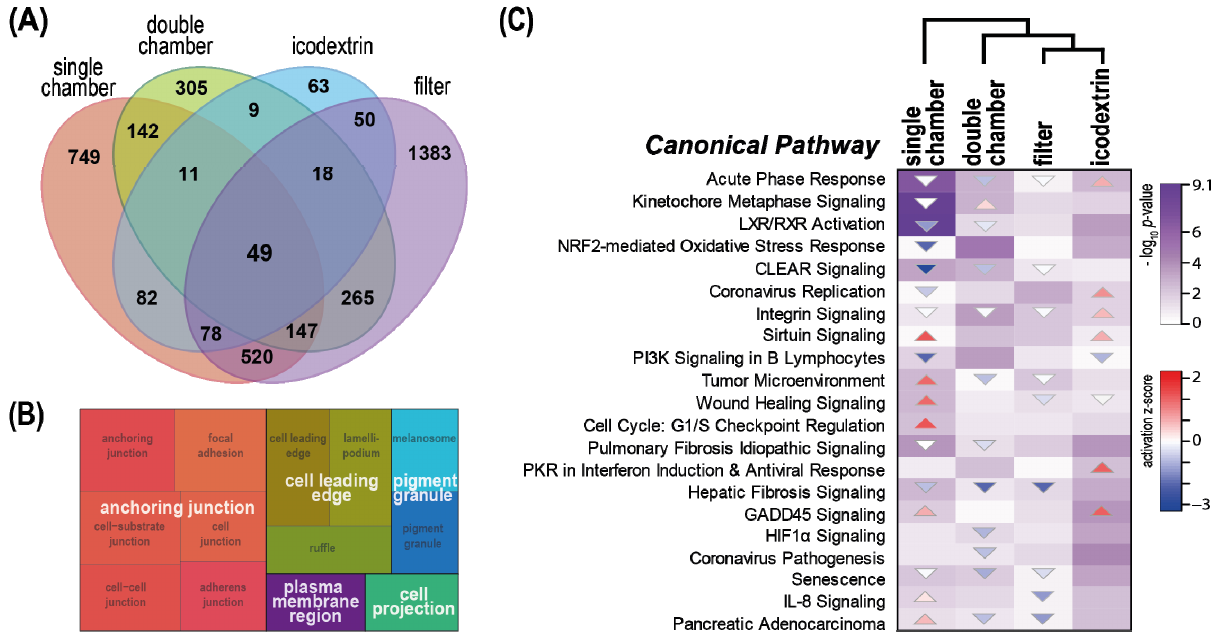
Figure 2. Common and differential effects of endothelial cells exposed to different PD fluids. ( A ) Venn diagram illustrating the overlap of significantly regulated ( p < 0.01) proteins following PD fluid exposure. ( B ) Gene ontology (GO) cellular component analysis of the 49 proteins identified to be significantly regulated (Fisher’s exact test, p < 0.01 BH corrected) by all PD fluids. Only GO categories with log 2 fold enrichment > 2 were further analyzed with the Revigo tool to summarize terms in a parental term, and the results are visualized as treemaps. ( C ) Heatmaps of significantly regulated canonical pathways (ingenuity pathway analysis, Fisher’s exact test p < 0.05) following PD fluid exposure compared with control medium. The p -value is visualized in violet by fill color intensity. Activation z-scores are indicated as up (activated; red) or down (deactivated; blue) colored arrows. The activation z-score is a calculated prediction of activation or inhibition of regulators based on relationships with dataset genes and direction of change of dataset genes. It represents the bias in gene regulation that predicts whether the upstream regulator exists in an activated or inactivated state. The direction of the arrow reflects the direction of the regulation (predicted activation: up, predicted inhibition: down).